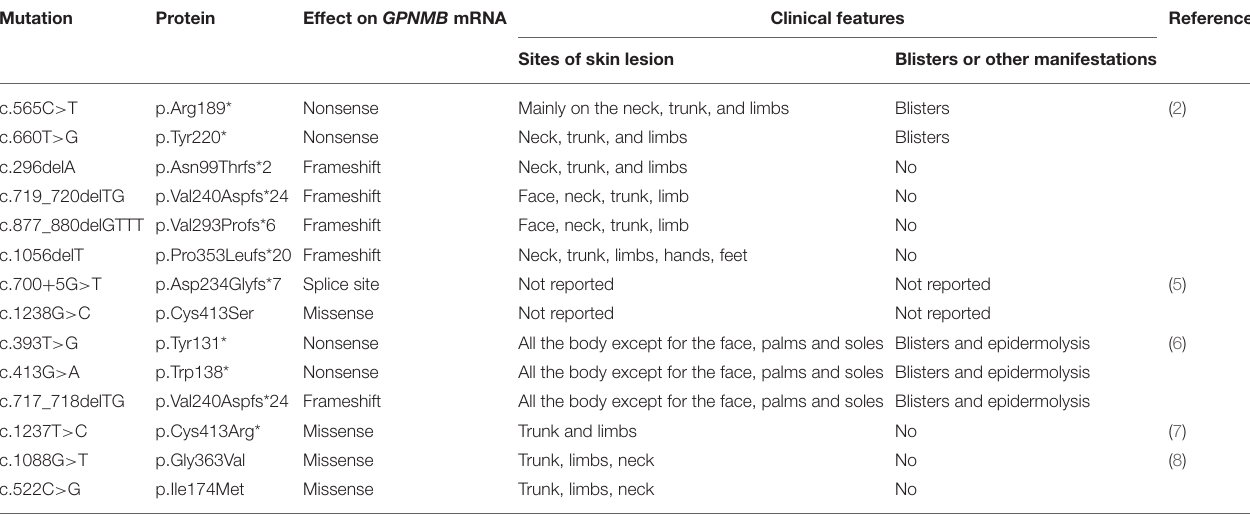
TABLE 1 | Amyloidosis cutis dyschromica (ACD)-related gene mutations reported in the literature published in PubMed from January 1970 to March